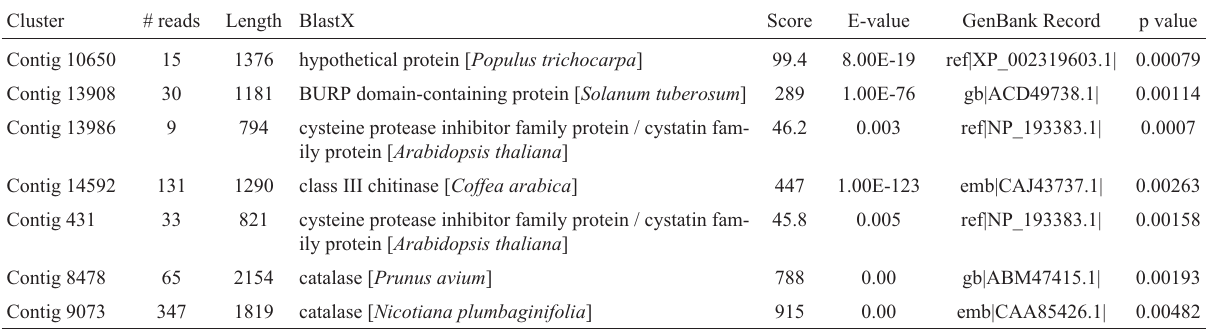
Table2 -ContigsdifferentiallyexpressedbetweenlibrariescontainingtheresponsestobioticstresschallengesandotherlibrariesfromtheBrazilianCof- fee Genome Project. Differential expression was confirmed by Fisher’s exact test, with the p values indicated in the last column.